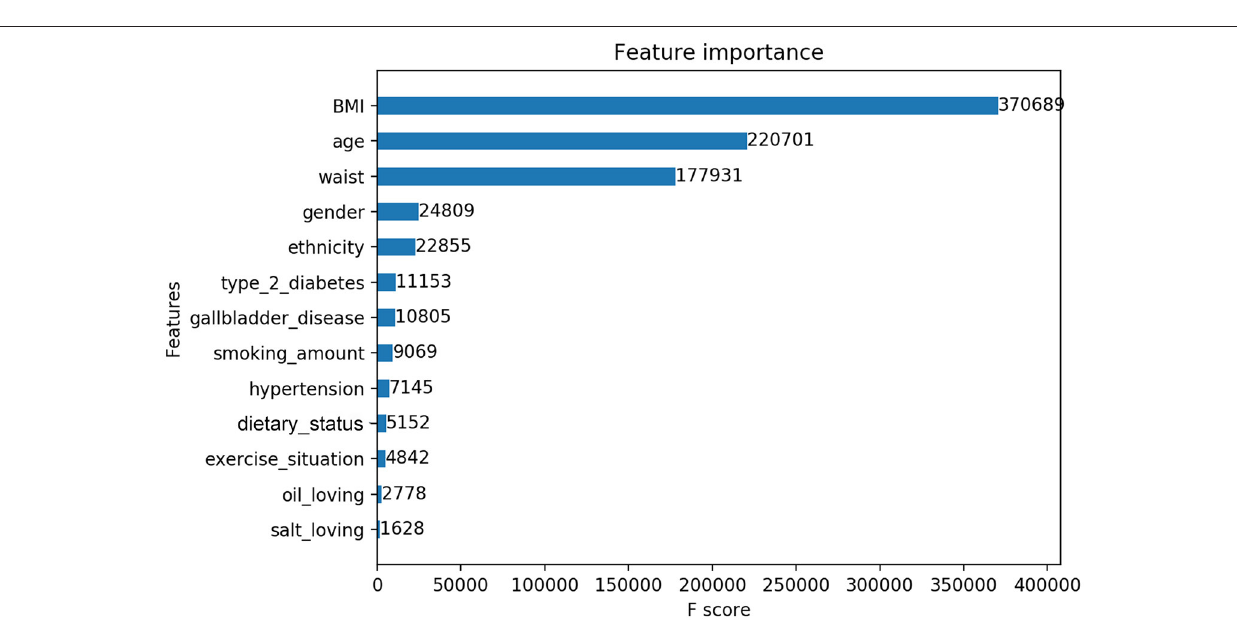
FIGURE 4 | Feature importance contributed to the XGBoost model measured by